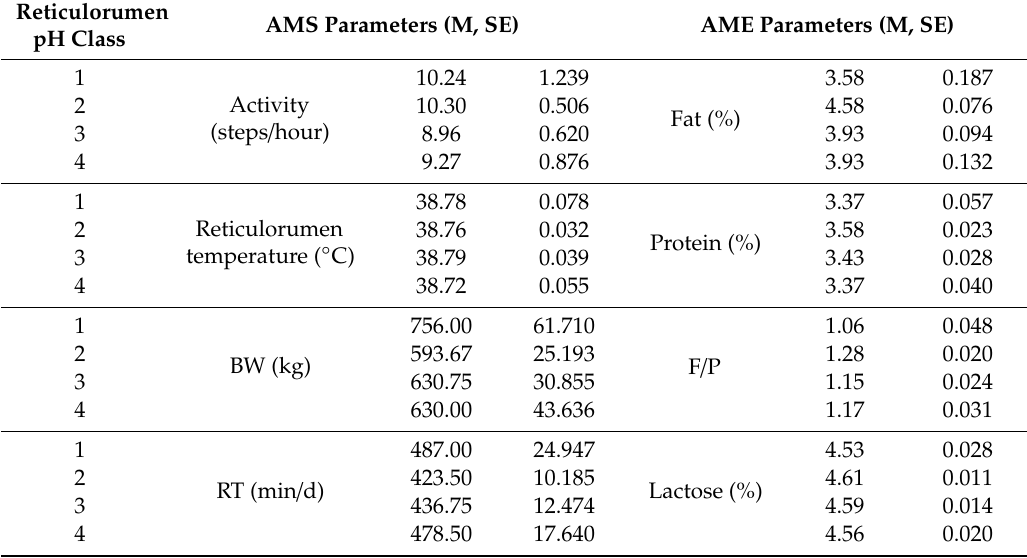
Table 2. Influence of reticulorumen pH and reproductive status on automatic milking system (AMS) indicators and milk traits of cows.